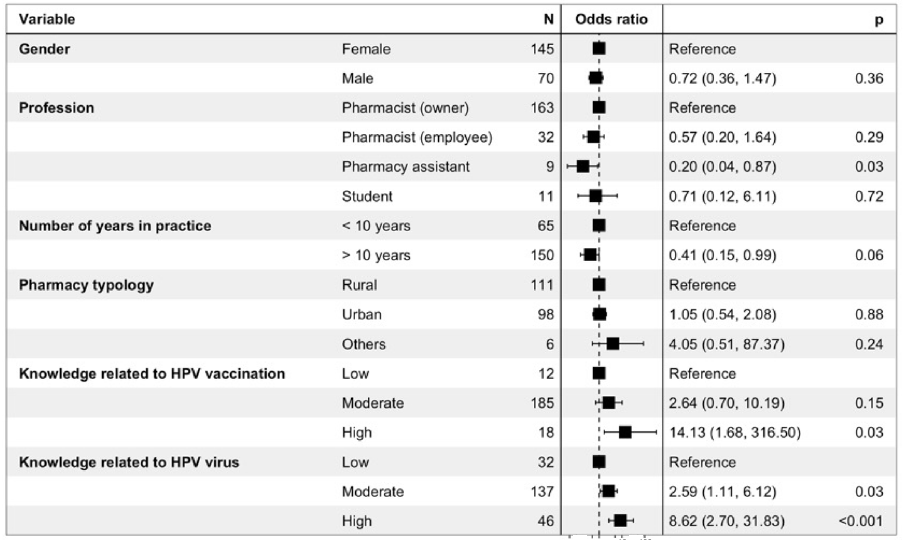
Figure 6. Binary logistic regression performed to evaluate the determinants of the right attitude toward HPV vaccination in general. The right attitude toward HPV vaccination in general corre ‐ sponded to respondents that (i) were highly or very highly confident in HPV vaccines, (ii) felt com ‐ fortable or rather comfortable arguing with questions about vaccines in general, (iii) felt comfortable or rather comfortable arguing with questions about HPV vaccines, (iv) felt concerned about HPV, and (v) found that promoting HPV vaccination is part of pharmacists’ roles.